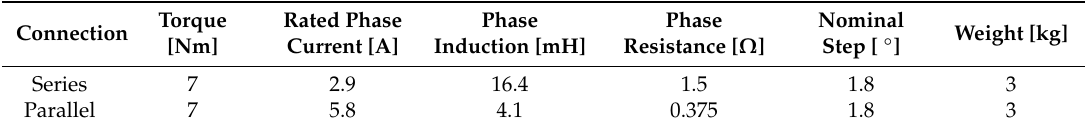
Table 2. Parameters for a universal two-phase step motor.